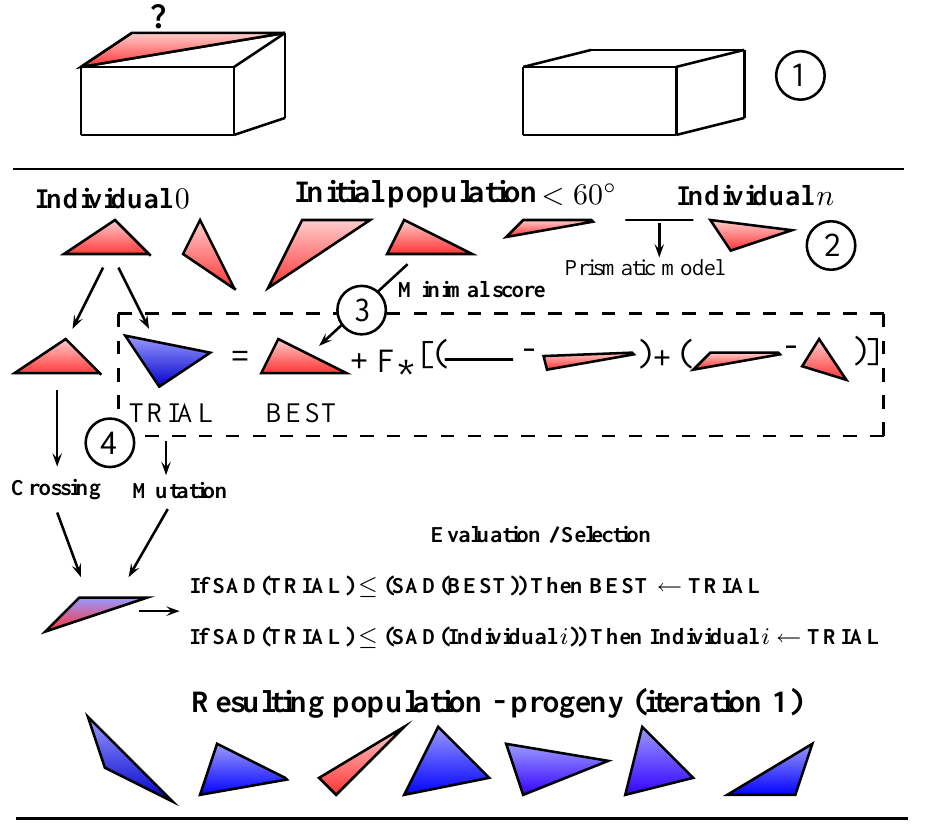
Figure 9. Illustration of one iteration of the DE